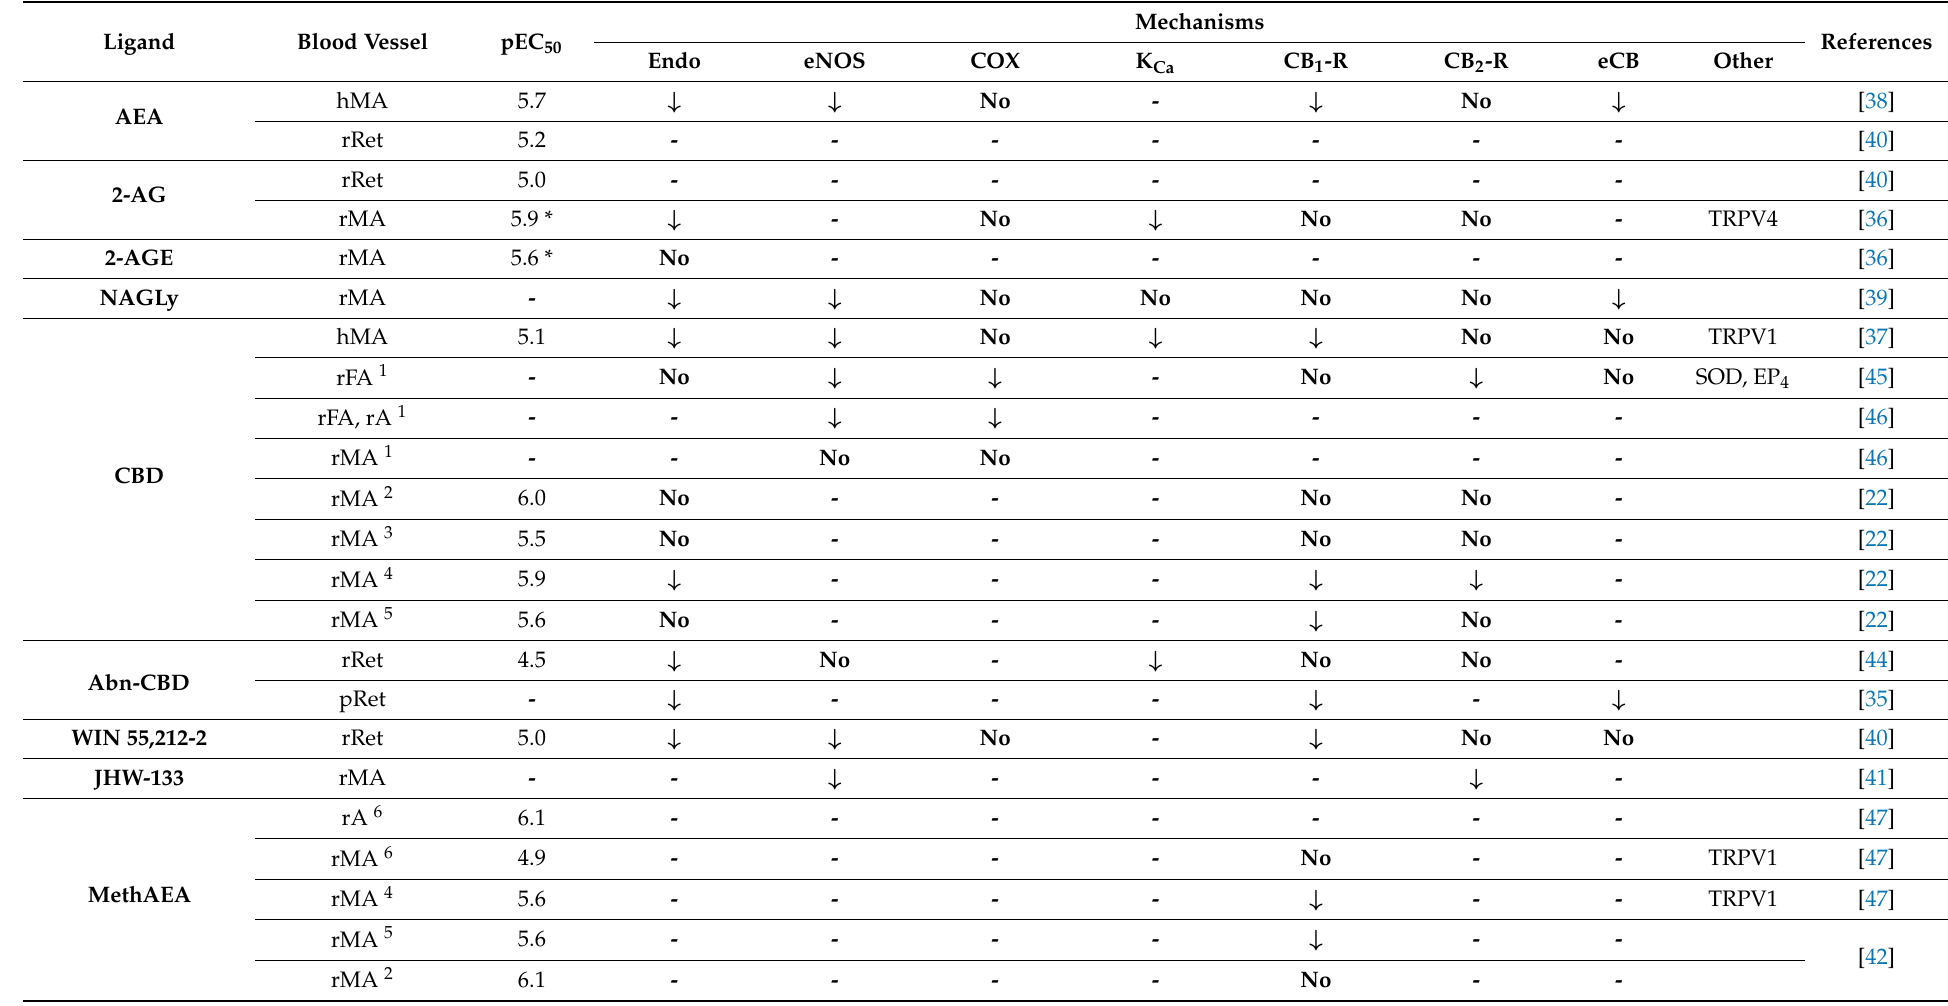
Table 2. The relaxing effects of cannabinoids on systemic vessels (published after